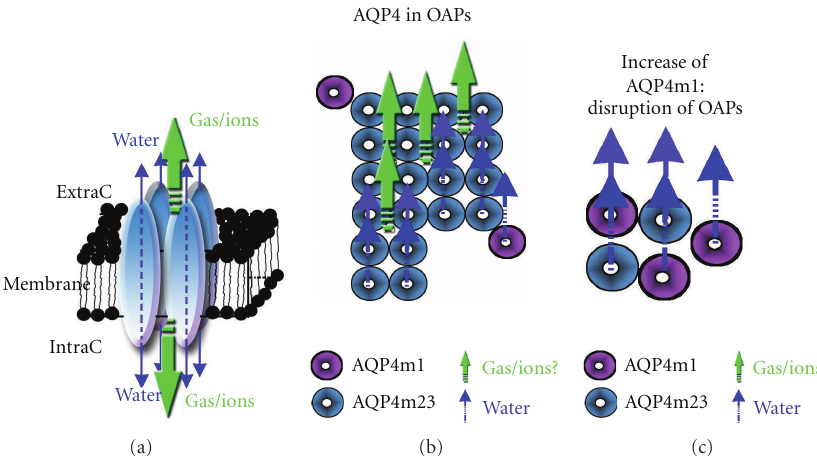
Figure 2: (a) Schematic drawing of the aquaporin homotetramer assembly within the lipid membrane: the central pore is proposed to be permeable to cations and gases (green arrows). Each individual aquaporin facilitates bidirectional water movement depending on the osmotic gradient (blue arrows). (b) AQP4 homotetramer is assembled in a higher structure named orthogonal array of particles (OAPs). Two isoforms of AQP4, AQP4-M1 (purple circles) and AQP4-M23 (blue circles) isoforms, contribute to the formation of OAPs. In vitro experiment showed that higher expression of AQP4-M23 contributes to the formation of larger OAPs. (c) Increase of AQP4-M1 induced disruption of OAPs. Recent knowledge on AQP leads us to hypothesize that the large OAPs contribute to gas and cation di ff usion in the astrocyte membranes through central pores (green